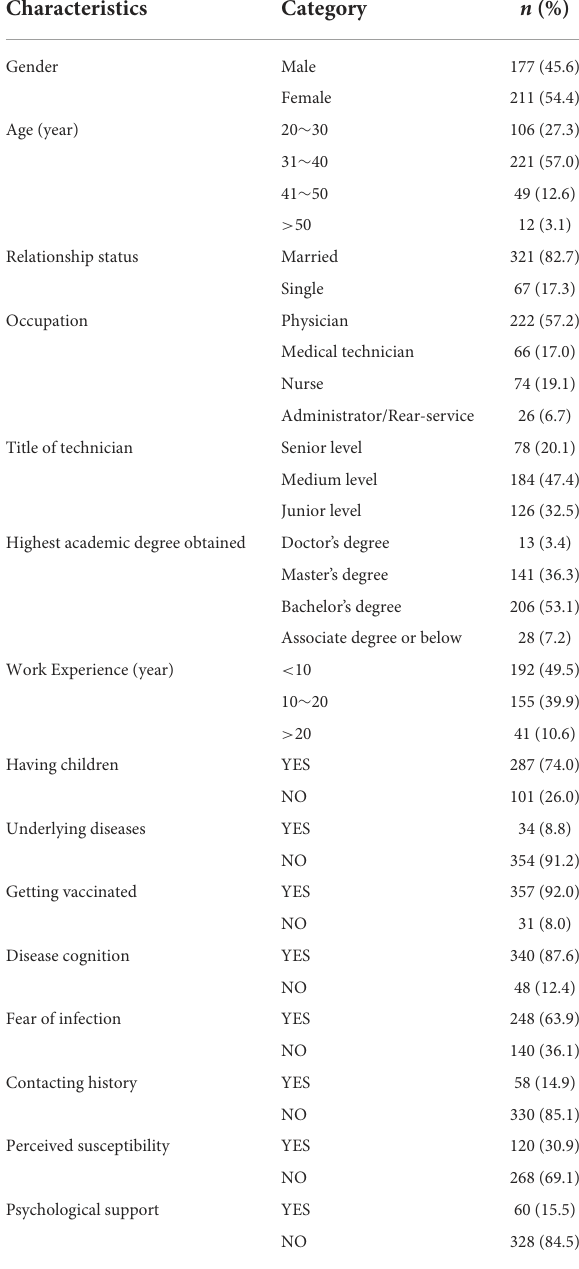
TABLE 1 Socio-demographic characteristics and COVID-19 related surveys of respondents.